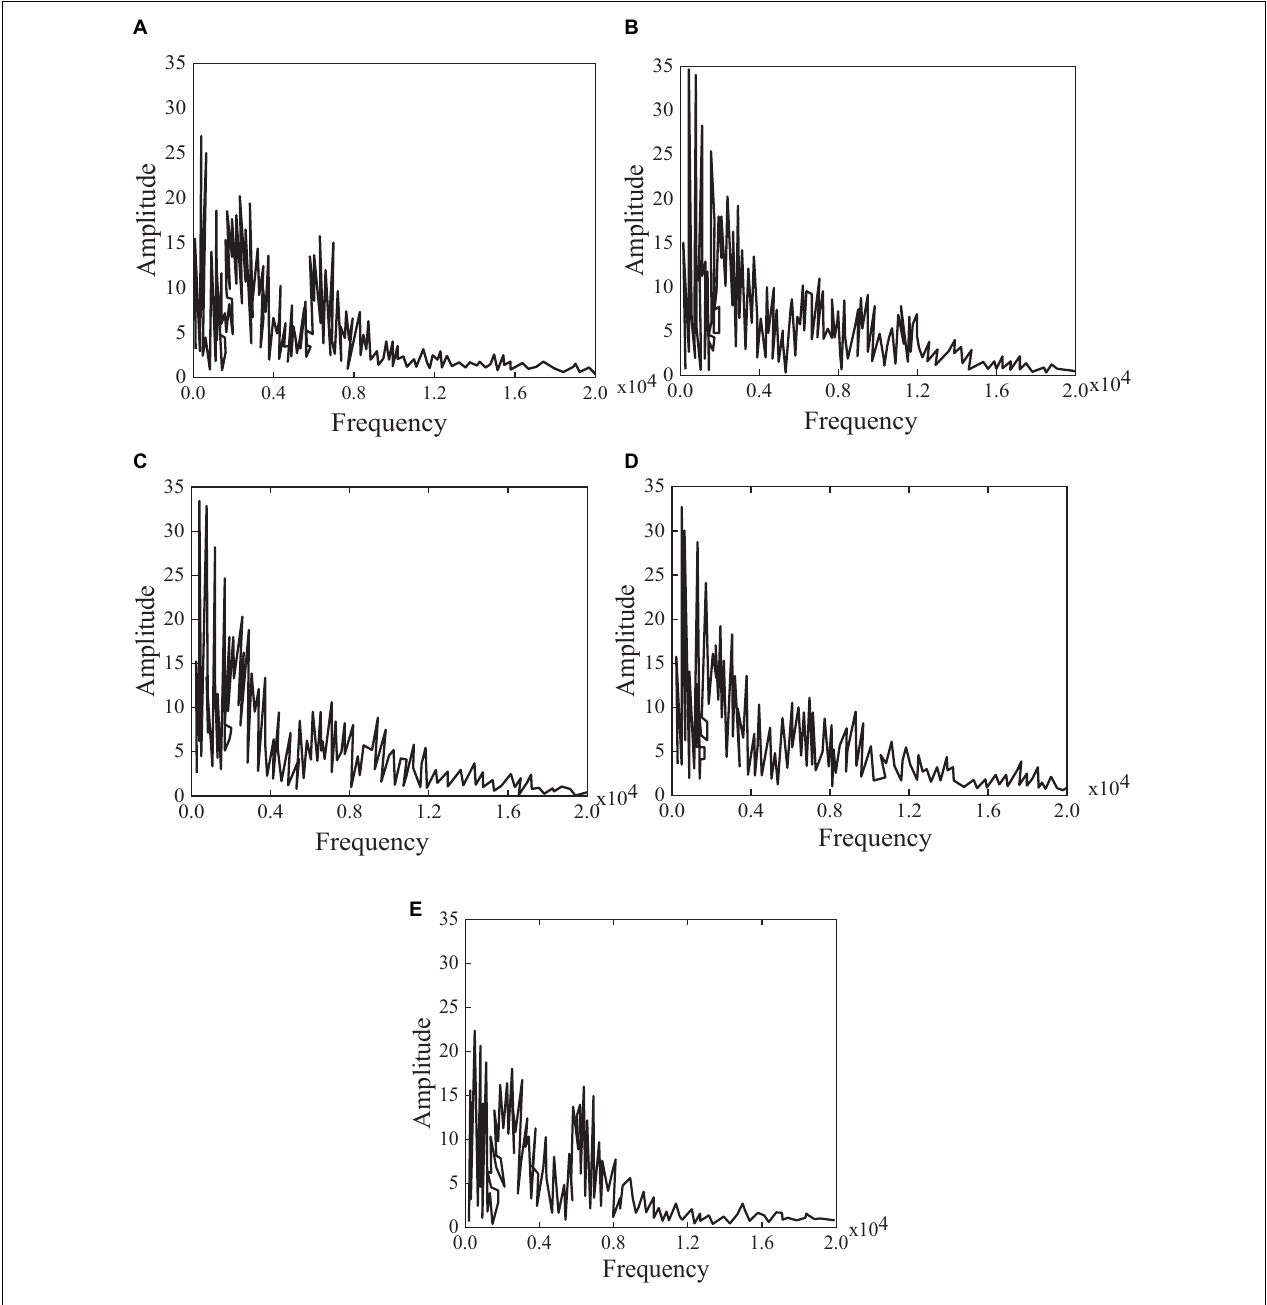
FIGURE 8 | Generated music spectrum and sample spectrum (A) original music; (B) one hidden layer; (C) two hidden layers; (D) three hidden layers; (E) four hidden layers.